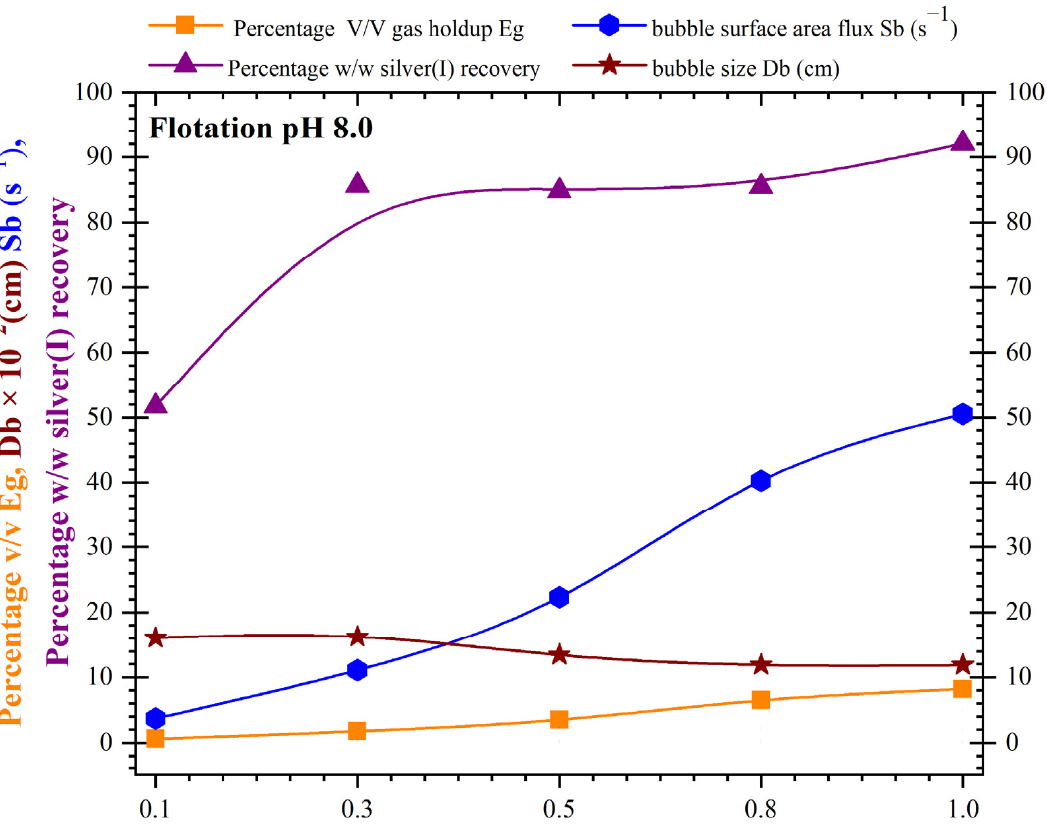
Figure 14. Eg, Db, Sb, and % w / w of silver(I) ion flotation as a function of superficial gas velocity, ceramic sparger, Jl 0.19 cm/s, system 1.89 × 10 − 4 [x]–1.29 × 10 − 4 [xl2945] M, and pH 8.